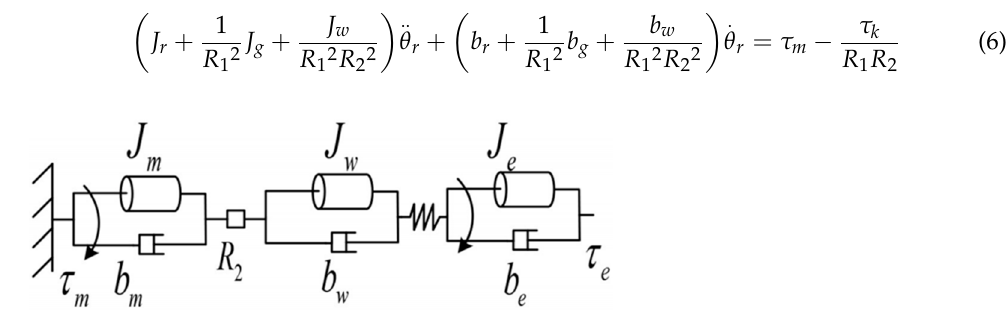
Figure 2. Schematic diagram of the NSA.